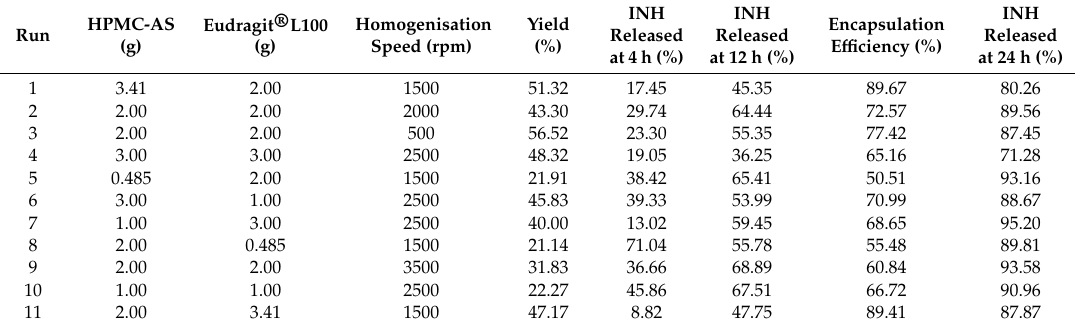
Table 5. Actual experiments conducted and responses observed using the hybrid Design of Experiments (DOE).